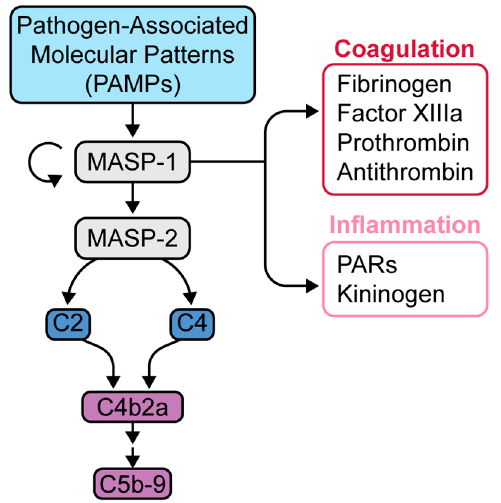
Figure 3. Mannose-binding lectin pathway and downstream effects. Initiation of the lectin pathway leads to the activation of MASP-1, which is capable of further autoactivation as well as activation of MASP-2. MASP-2 is responsible for the generation of subsequent anaphylatoxins and MAC. MASP-1 has much more relaxed substrate specificity, rendering additional effects in the coagulation and inflammatory cascades. Adapted from Dobo et al. [25].